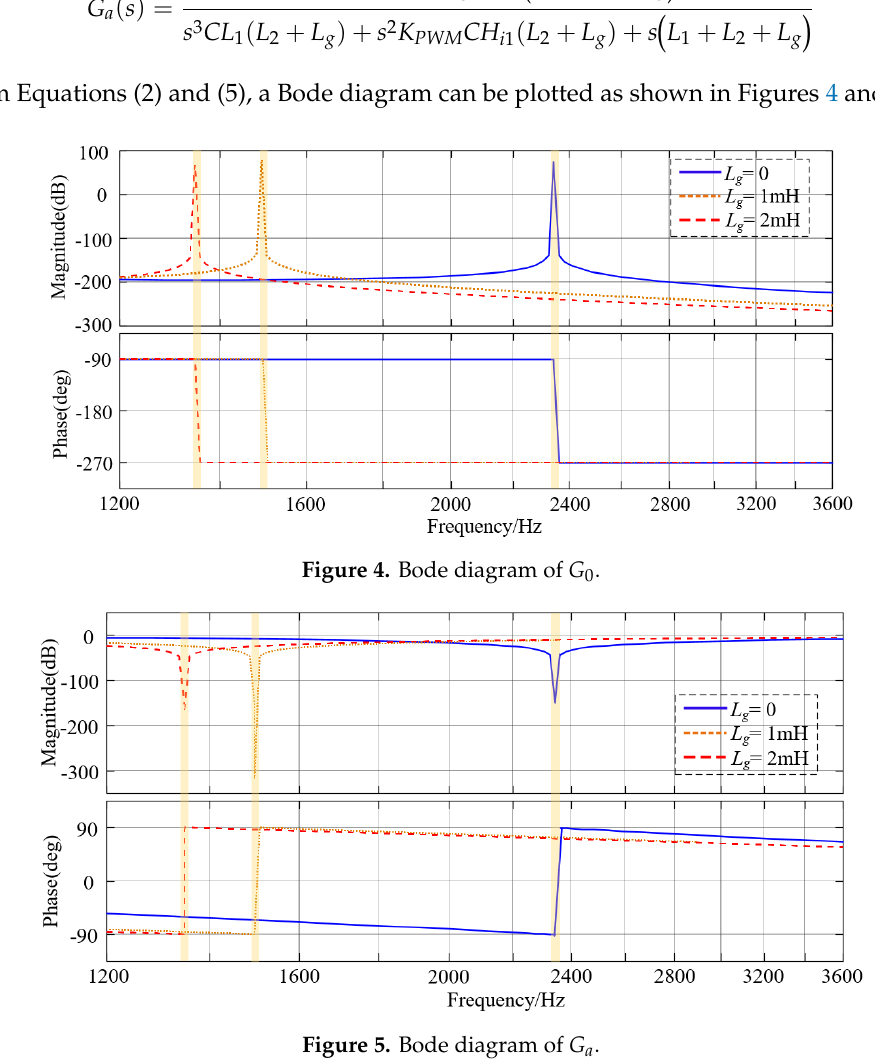
Figure 5. Bode diagram of G a .